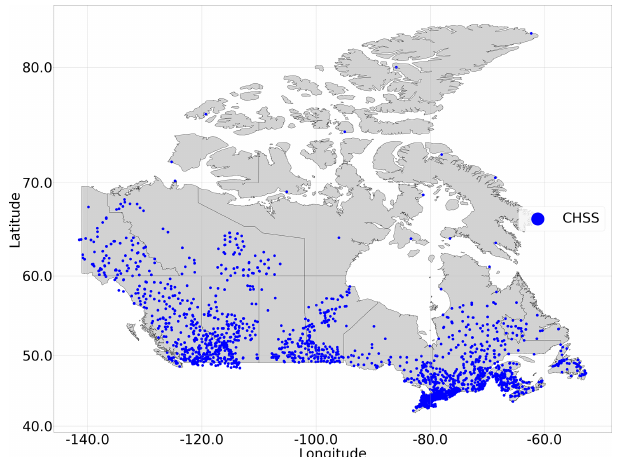
Figure 4. Location of the sites of the Canadian historical snow sur- vey (CHSS) data